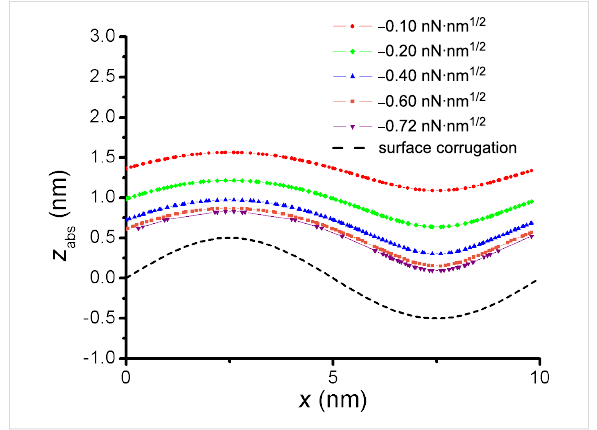
Figure 6: Contours of constant normalized frequency shift, γ , for a corrugated surface. Attenuation is observed as the distance from the surface increases. Here, z abs gives an absolute position in the z direc- tion, not a relative distance from the